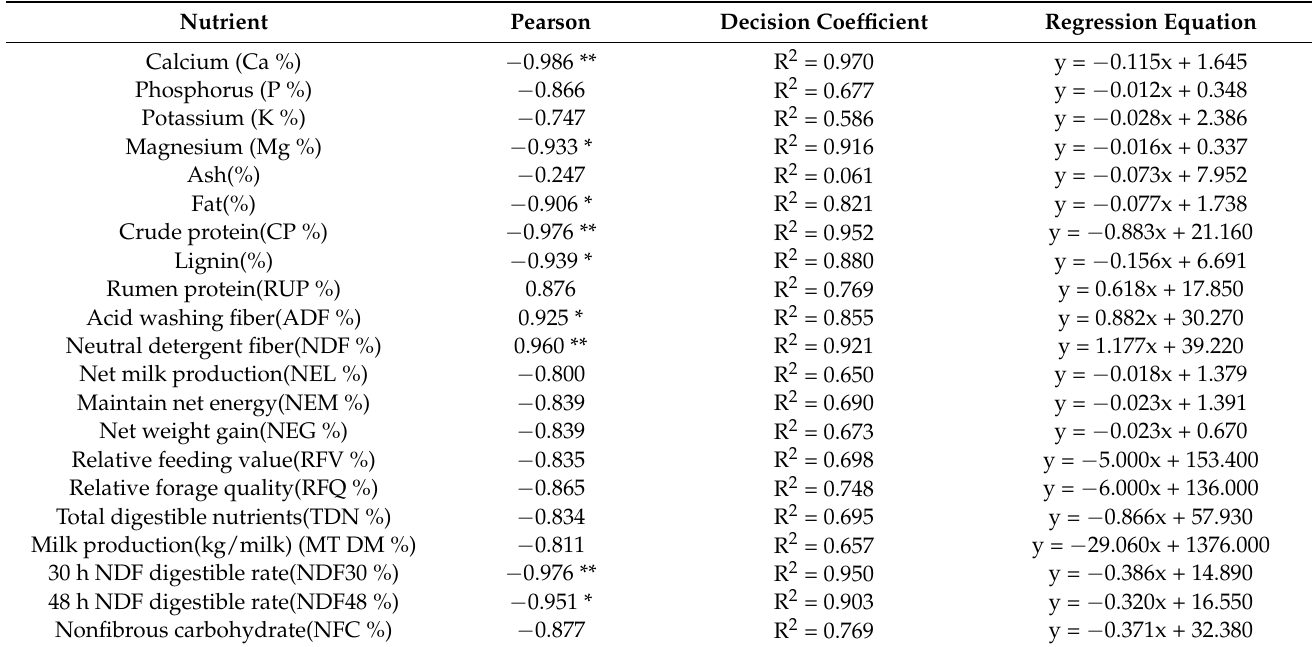
Table 5. Correlation between the severity of alfalfa Leptosphaerulina leaf spot and alfalfa plant nutrient